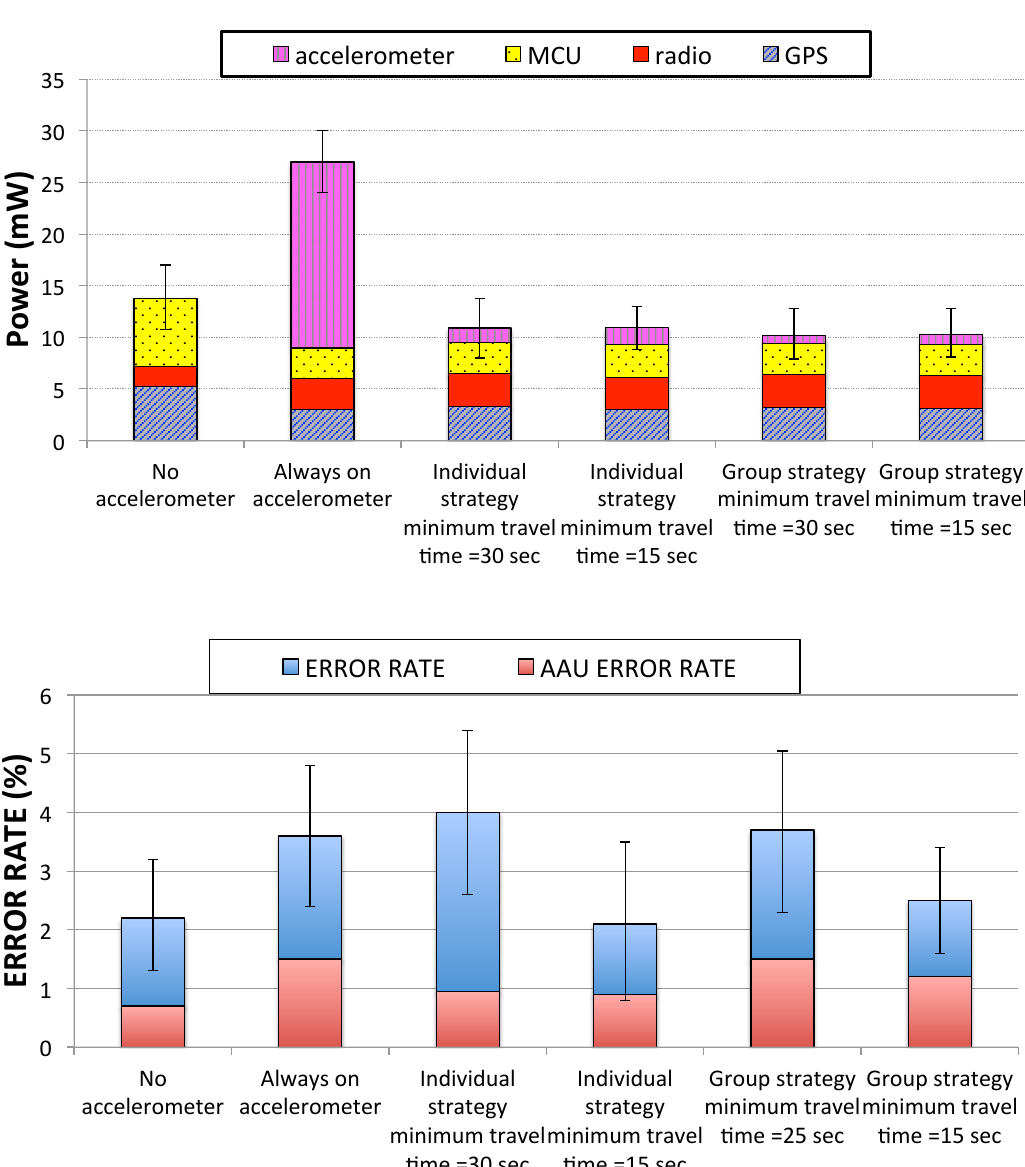
Figure 22. Power consumption and accuracy for the 3-hour interval in the data trace with the highest number of motion